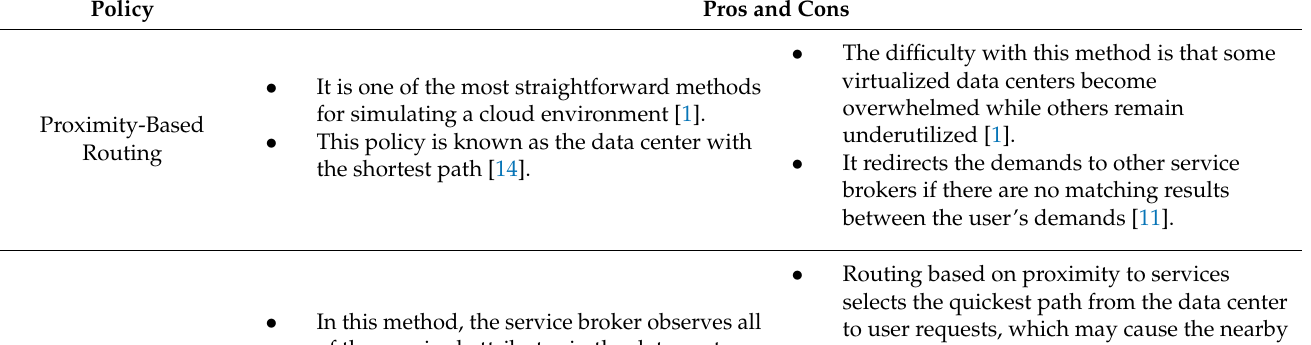
Table 3. Pros and cons of service broker policies in cloud computing environments. Pros and